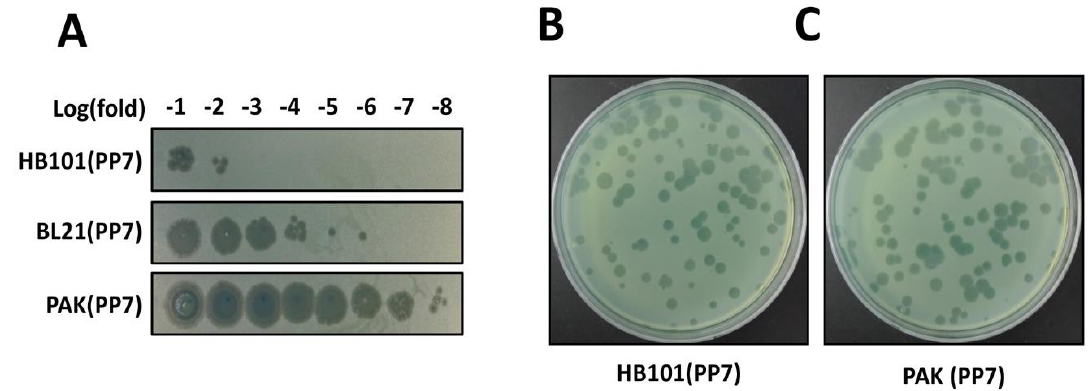
Figure 3. Determination of phage titers. ( A ) Spotting assay for rapid determination of the phage titers. Phage titers were roughly determined using the serially diluted samples from the culture supernatants of the surrogate hosts bacteria, HB101(PP7), PAK(PP7), and E. coli BL21(DE3)pLysS containing the cloned PP7 cDNA. The numbers in the log(fold) ( − 1 to − 8) designate the logarithmic values of the dilution folds to base 10 of the culture supernatants from the indicated PP7-producing bacteria B and C. Plaque assay for precise determination of the phage titers. Appropriately diluted samples from HB101(PP7) ( B ) or PAK(PP7) ( C ) clones were mixed with ~10 7 cfu of PP7-susceptible P. aeruginosa PAO1. Plaques were visualized after incubation at 37 °C for 18 h.